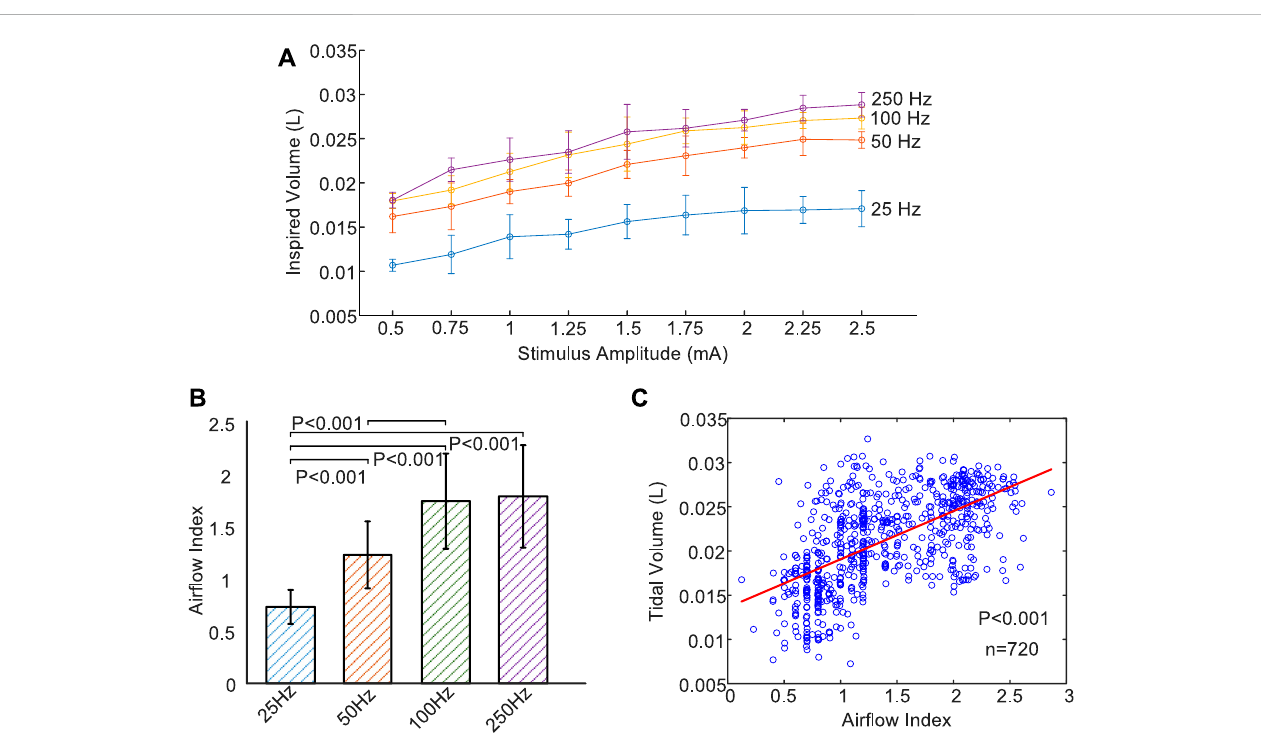
FIGURE 6 Changes of inspired volume and Air fl ow Index under different stimulus parameters. (A) Relationship between evoked tidal volume and incremental stimulus amplitudes for four stimulus frequencies (25, 50, 100, and 250 Hz). Inspired volume gradually increase with increase of stimulus current until it basically reachedsaturationat2 mA. (B) MeanAir fl owIndexduring DPfor four differentstimulus frequencies(25, 50,100, and250 Hz).Bvaluesincrease with increasing stimulus frequency. (C) Correlation analysis between Air fl ow Index and inspired volume using scatter plot. The least squares regression line is represented by a solid red line. Strong correlation ( r = .60, n = 720, p < .001) is observed between Air fl ow Index and inspired